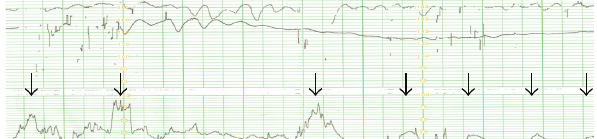
Figure 1: Cardiotocogram indicated absent variability in the right twin (I), and reassuring pattern in the other left twin (II), showing uterine contractions every one to three minutes. Arrows indicate uterine contractions.